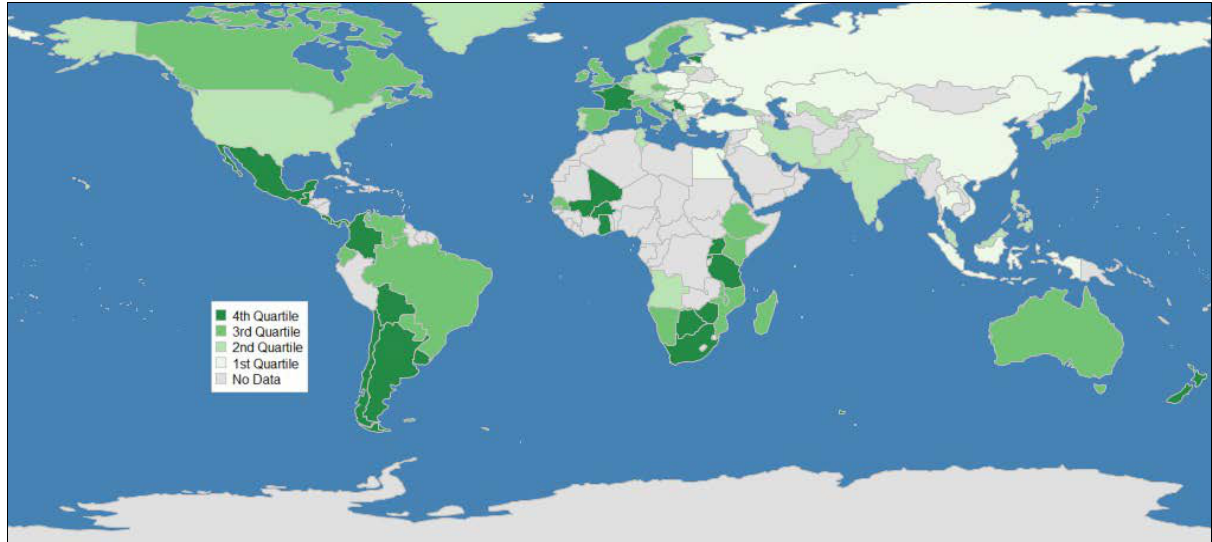
Figure 1: Proportion of responding scientists by country (1 November